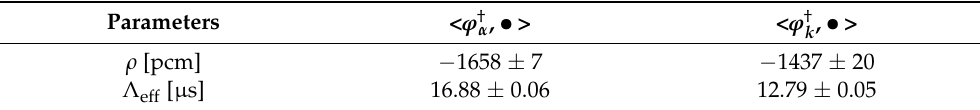
Effective kinetics parameters of Problem III, sub-critical configuration without delayed contributions.